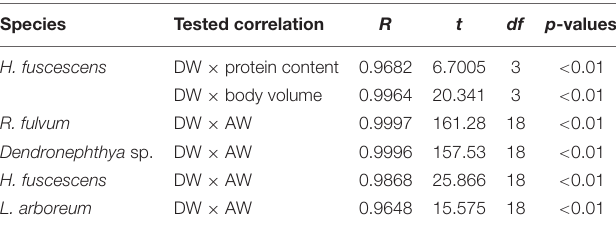
TABLE 3 | Significant correlations between dry weight (DW), protein content, body volume, and ash weight (AW), of Heteroxenia fuscescens , Rhytisma fulvum , Dendronephthya sp., and Litophyton arboreum